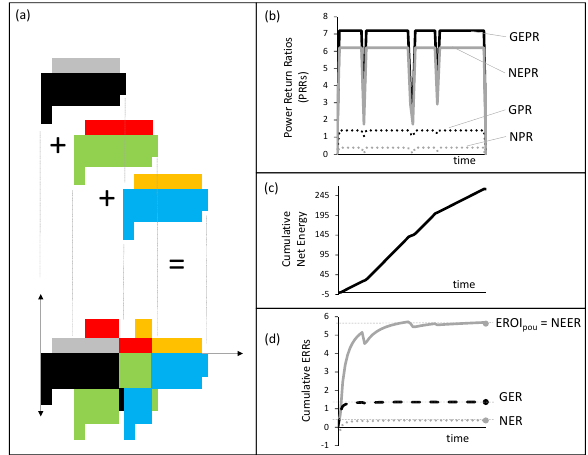
Figure 2. The power flows and energy relations among various factors that are used to calculate energy return ratios (ERRs) for three of the same single energy technologies’ life cycle installed at different times. ( a ) Pictogram depicting the technology being installed at three different times. The bottom image shows the power inputs and outputs for the sum of all three installations; ( b ) The instantaneous power return ratios (PRRs) are defined the same as ERRs, except using only instantaneous power flow data rather than power integrated over time; ( c ) The cumulative net energy over time that is the integral of the instantaneous net power (net power = P out − P in ); ( d ) The cumulative energy return ratio (ERR) for three common ERRs. EROI 3 = EROI pou from [45] equal to the net external energy ratio (NEER) from [29,44,47]. Gross energy ratio (GER) and net energy ratio (NER) from